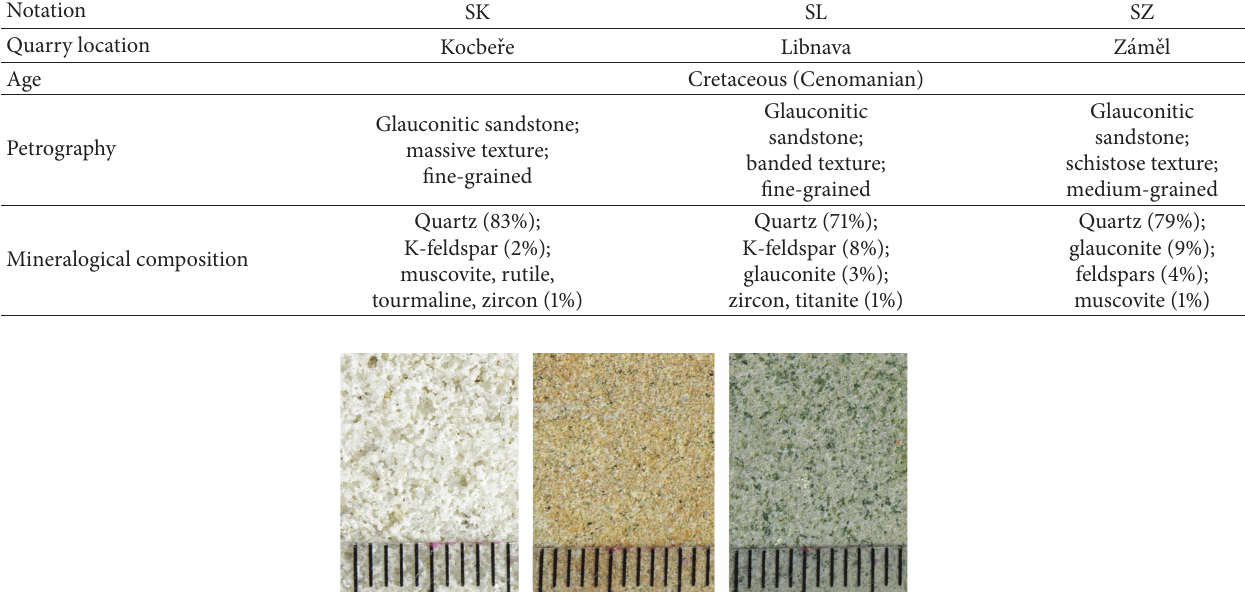
Figure 1: Images of investigated sandstones (SK-SL-SZ).